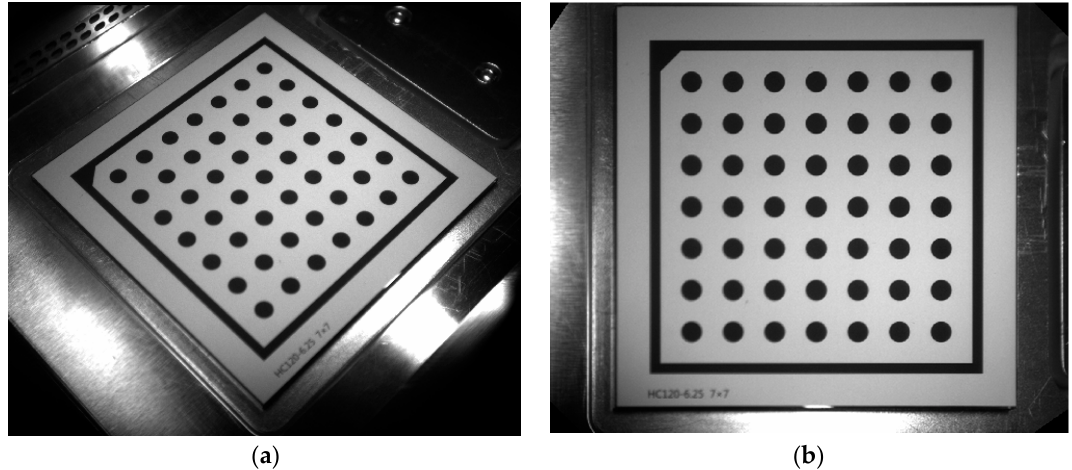
Figure 4. The perspective transformation effect: ( a ) Perspective transformation before. ( b ) After the perspective transformation.